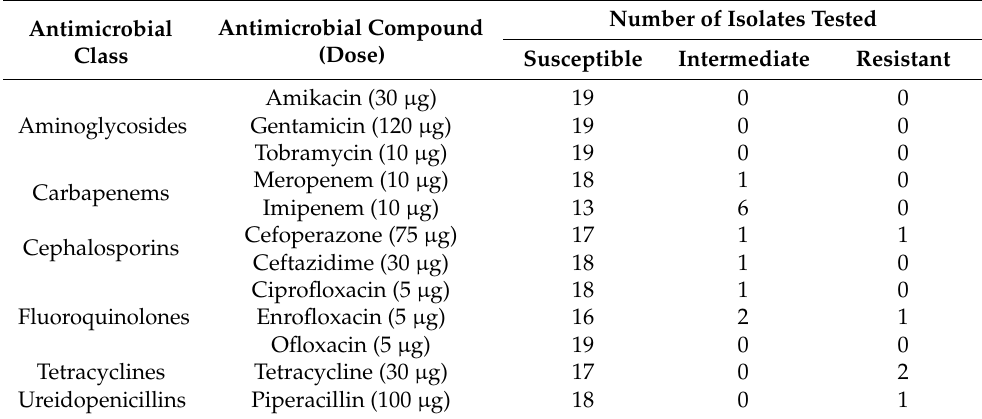
Table 1. Antimicrobial resistance of bacterial isolates from oral, cloacal, and egg content swab samples of 33 loggerhead turtles.